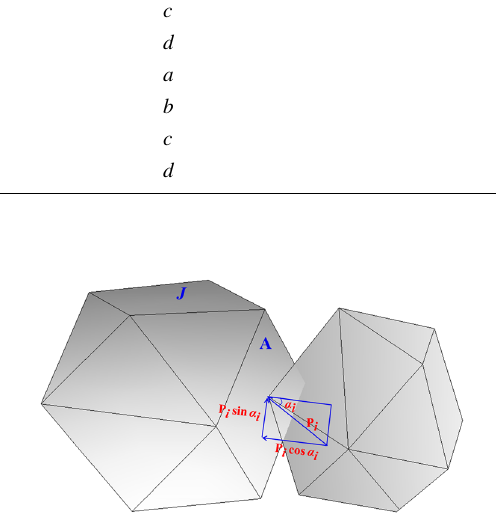
Fig. 10 Force analysis diagram of particles